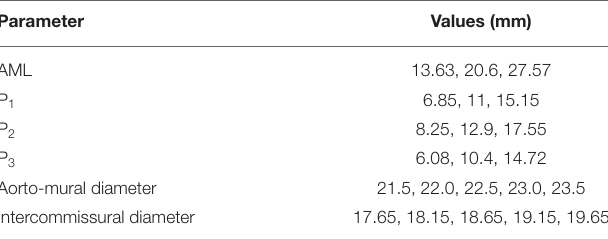
Frontiers in Cardiovascular Medicine |